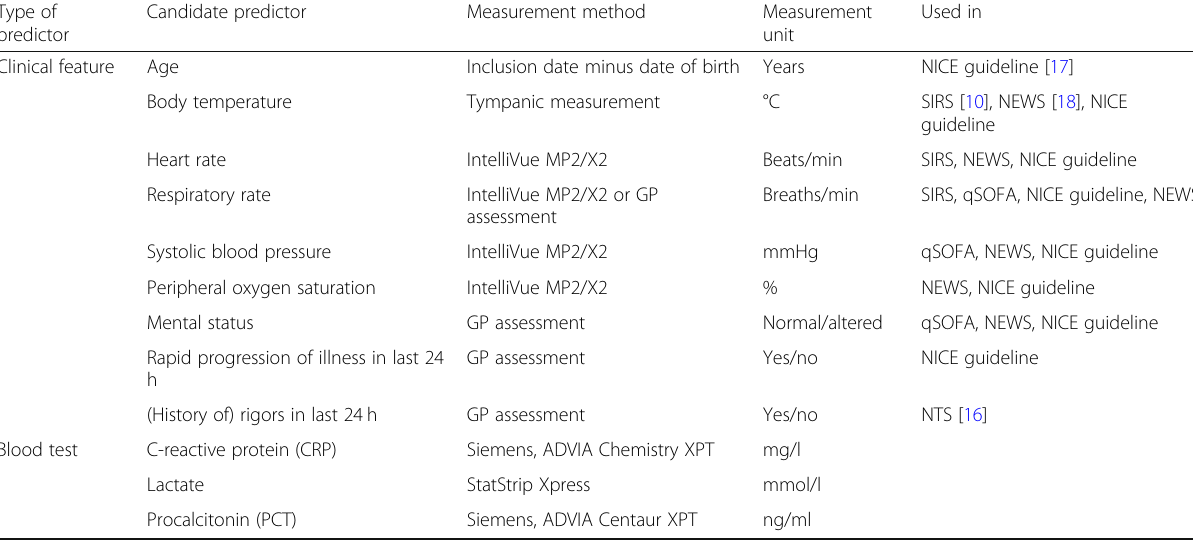
Table 1 Candidate predictors eligible for the selection in the prediction model Type of